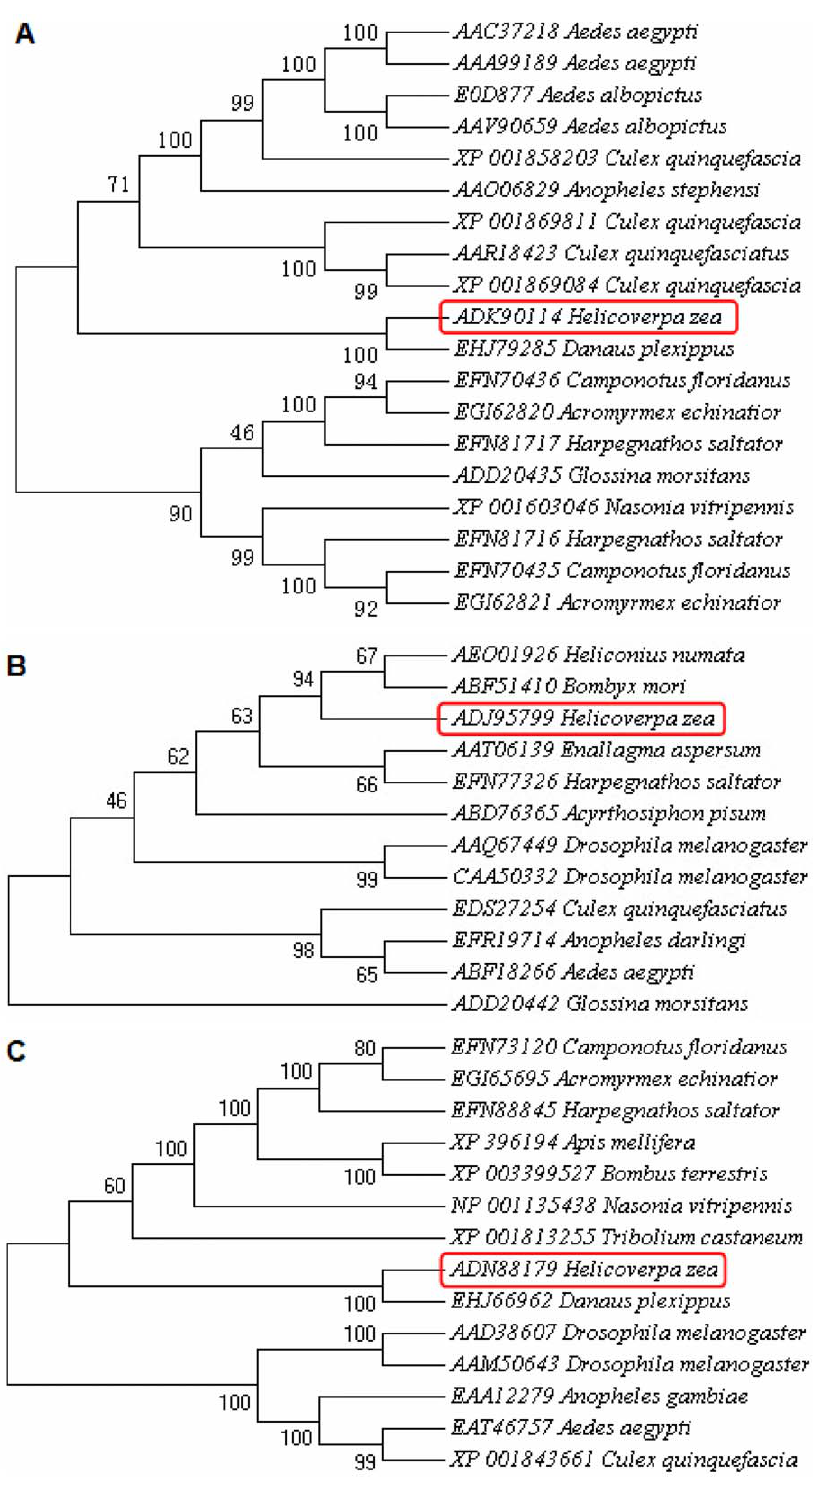
Figure 2. The molecular evolutionary trees of target proteins with amino acid sequences from other insect species. A , B , C represent the evolutionary trees for H. zea apyrase, ATP synthase and ATPase 13A1, respectively. The corresponding GeneBank accession numbers for H. zea apyrase, ATP synthase and ATPase 13A1 are ADK90114, ADJ95799 and ADN88179, respectively. doi:10.1371/journal.pone.0041947.g002 plays a role in the resistance to pathogens by inducing anine ammonia lyase (PAL) [32,33]. The second is the jasmonic pathogenesis-related proteins (PR) and other genes like phenylal- acid pathway (JA) [34]. When plants encounter herbivory, JA is